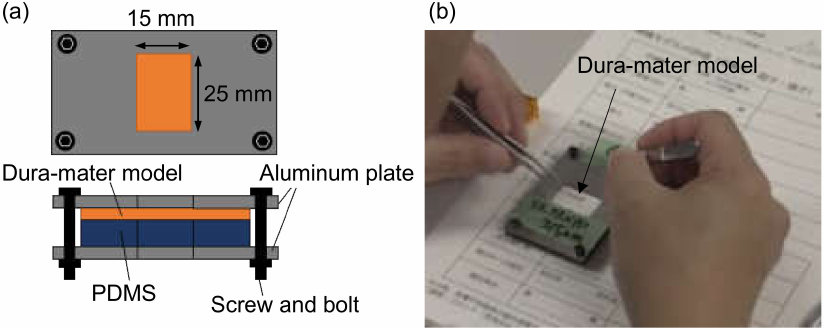
Figure 14. Sensory tests conducted by neurosurgeons: ( a ) Design of the specimen of the dura-mater model used for sensory tests; ( b ) Photograph acquired in the sensory